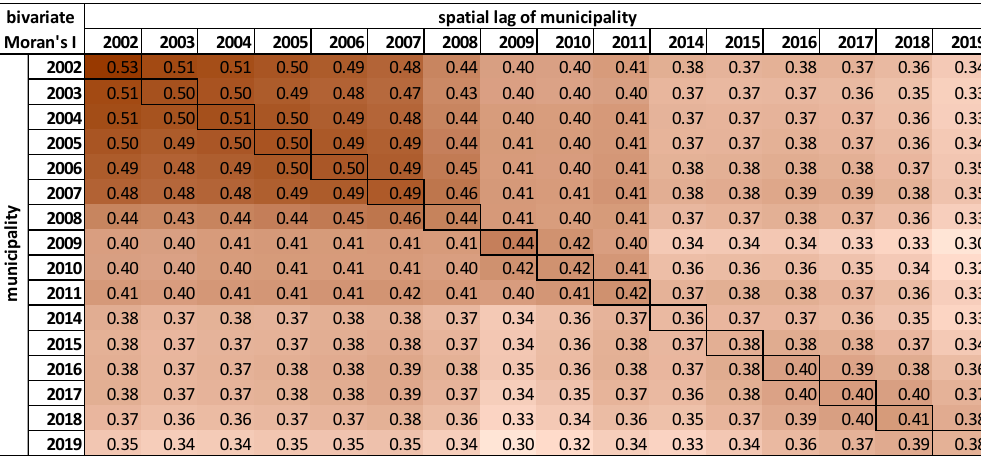
Figure 3. Bivariate Moran’s I , unemployment between 2002 and 2019 in Czechia (municipal level, yearly data). Source: Ministry of Labor and Social Affairs, Labor Office of the Czech Republic; own calculation. Note: Moran’s I is calculated based on spatial weights with the fixed Euclidean distance for the threshold distance of 10 km. All values are statistically significant at a 1% significance level based on 999 permutations. The shade of color corresponds to the level of spatial autocorrelation. The values on the diagonal represent univariate Moran’s I for respective years.